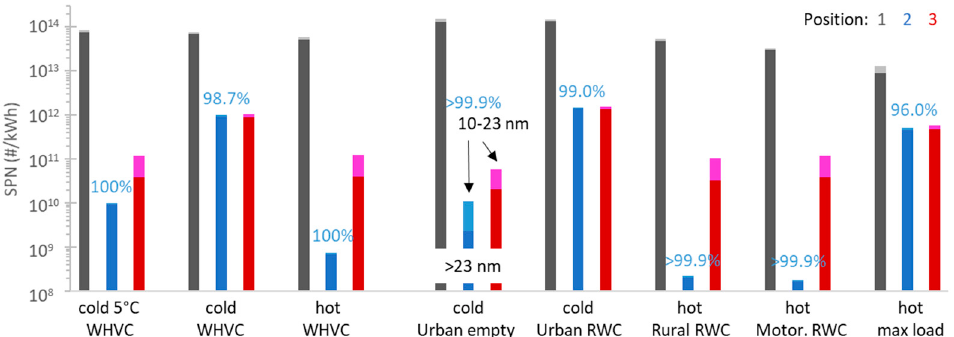
Figure 8. Solid particle number (SPN) emission factors for various cycles at different sampling positions of the aftertreatment system. SPN 23 and SPN 10 are given with different color shading. Position 1 (engine out, grey bars); position 2 (DOC + cDPF out, blue bars); position 3 (SCR + ASC out, tailpipe, red bars). Percentages give emissions reductions compared to the previous position. Tests at 23 ◦ C, except “cold 5 ◦ C WHVC”, and 66% of maximum payload, except “Urban empty” (9%). “Cold” and “hot” refer to the coolant temperature at engine cranking, i.e., at ambient temperature or >70 ◦ C, respectively. ASC = ammonia slip catalyst; DOC = Diesel oxidation catalyst; cDPF = catalyzed Diesel particulate filter; RWC = real world cycle; SCR = selective catalytic reduction; WHVC = world harmonized vehicle cycle.